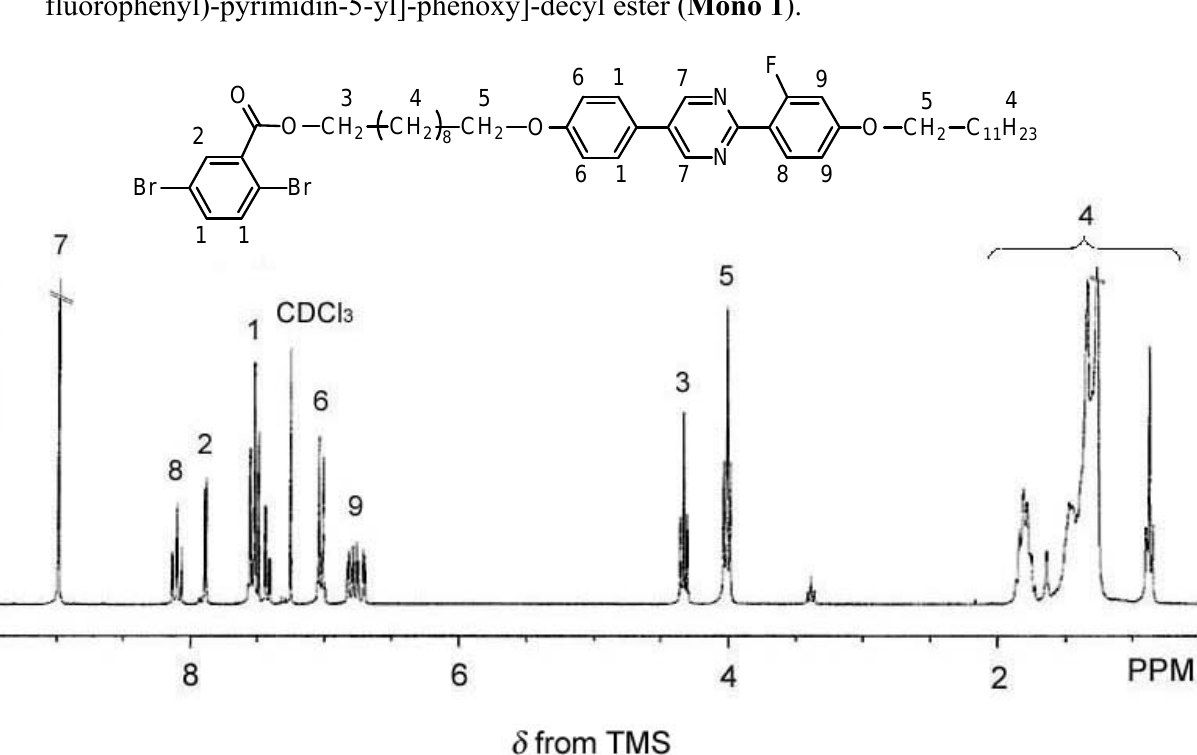
Figure 2. 1 H-NMR spectra of 2,5-dibromobenzoic acid